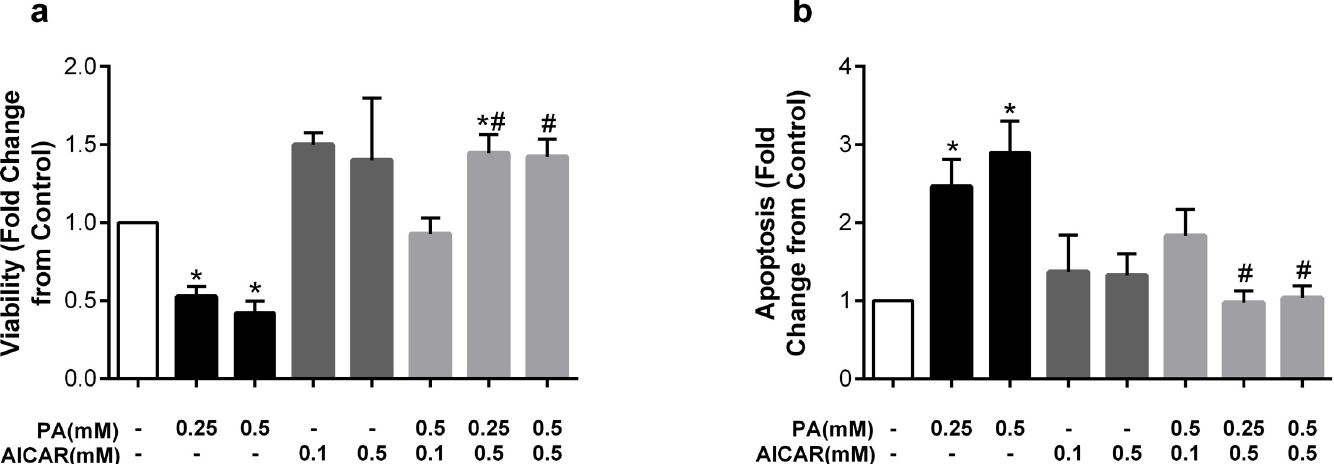
Fig 6. The AMPK activator AICAR prevents detrimental effects of palmitate. Cells were pretreated with AICAR (0.1 or 0.5mM) for 2hr then co-incubated with palmitate (PA). Fold change from control in a) viability and b) apoptosis after treatment with palmitate (PA), AICAR, or a combination of both. Data are expressed as mean ± SEM; n = 2–6 independent experiments; � p < 0.05 vs control, #p < 0.05 vs both PA concentrations.